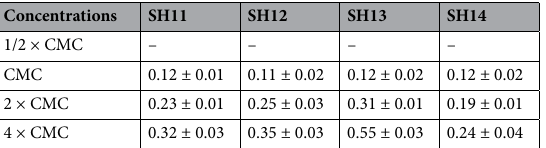
the soil. Moreover, from day 1 to day 7, the rate of TPH release decreased due to the lack of antibacterial prop- erties in this surfactant, which exposed it to more degradation by soil microorganisms (Fig. S5c). The reasons